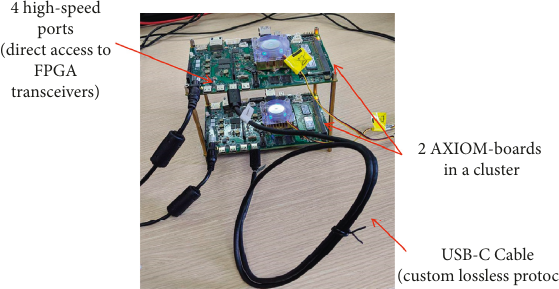
Figure 15: Average data latency in the COTSon framework when using the matrix multiplication benchmark with 512 as the matrix size and 32KiB as the cache size. We varied the number of nodes of the distributed system and the Linux distribution (“xenv0” “karmic64” Ubuntu 9.10, “trusty-axmv3” Ubuntu 14.04, and “tfxv4” Ubuntu 10.10). The data access latency of “xenv0” is improved (cid:31) (cid:31) (cid:31) when we have more nodes. This improvement has less impact on total cycles (Figure 12) than the impact of kernel activity (Figure 11).